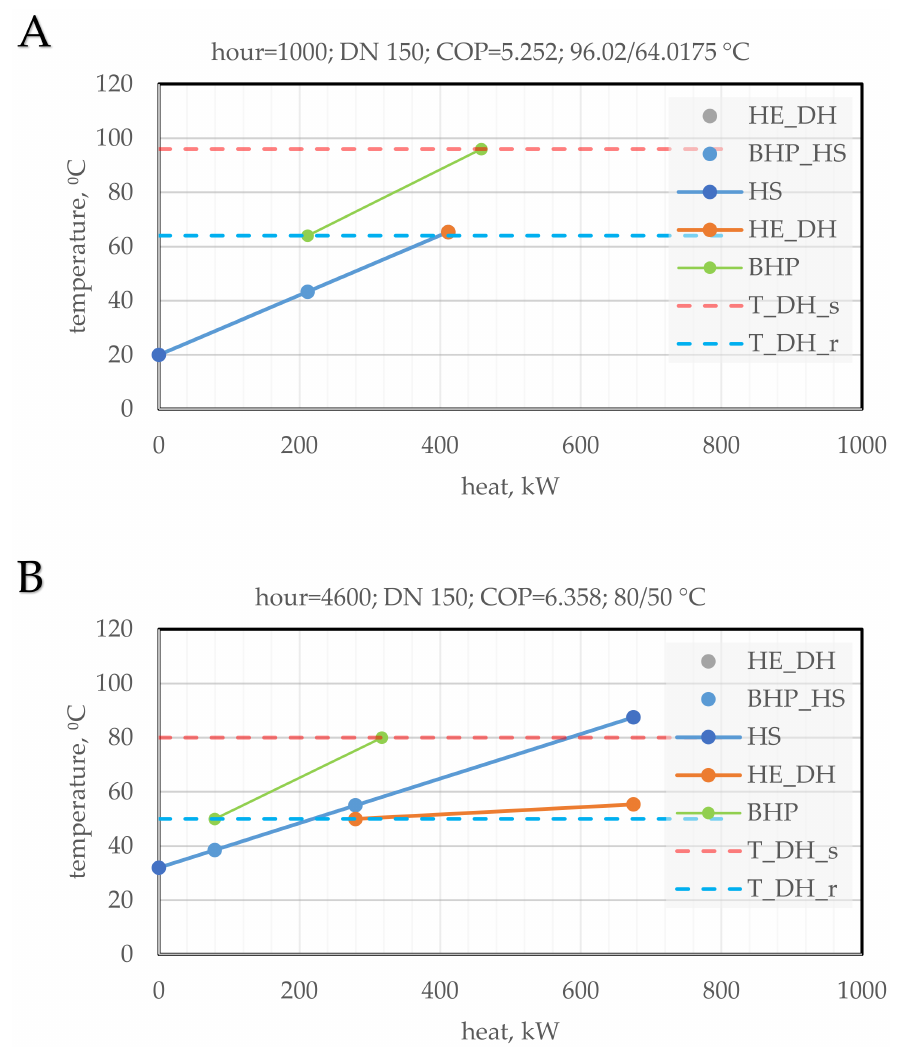
Figure 12. Pinch analysis results—Scenario A. ( A ) BHP utilization; ( B ) BHP and HE utilization.